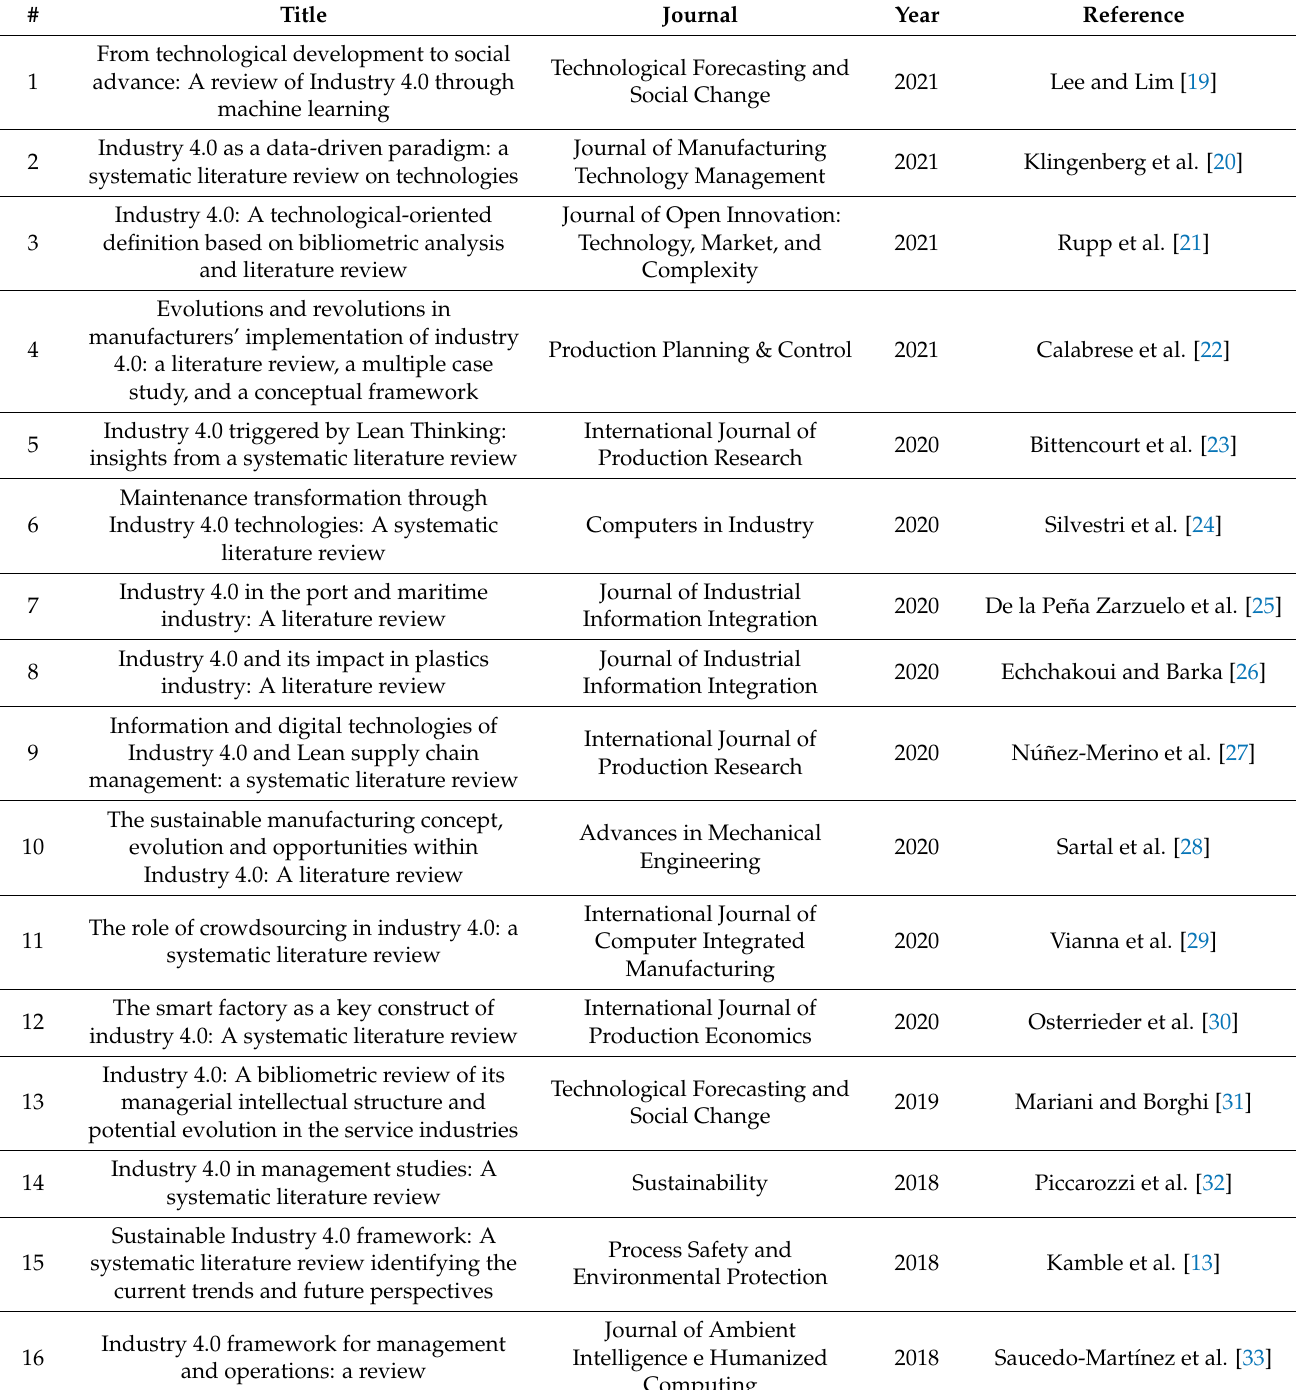
Table 1. I4.0 review papers published between 2018 and